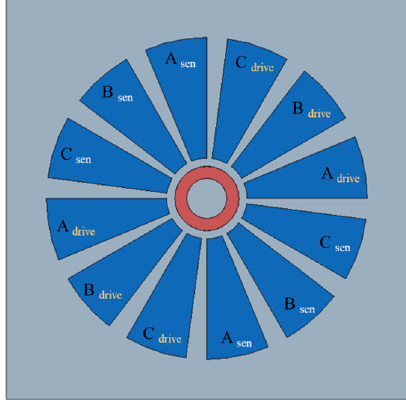
Figure 5. Input voltage supply strategy for simultaneous driving and sensing.